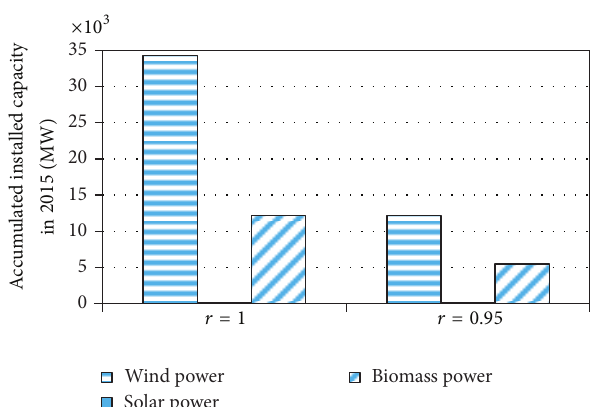
Figure 5: The impact of discounting rate, 𝑟 , on the accumulated installed capacities of renewable power in 2015.